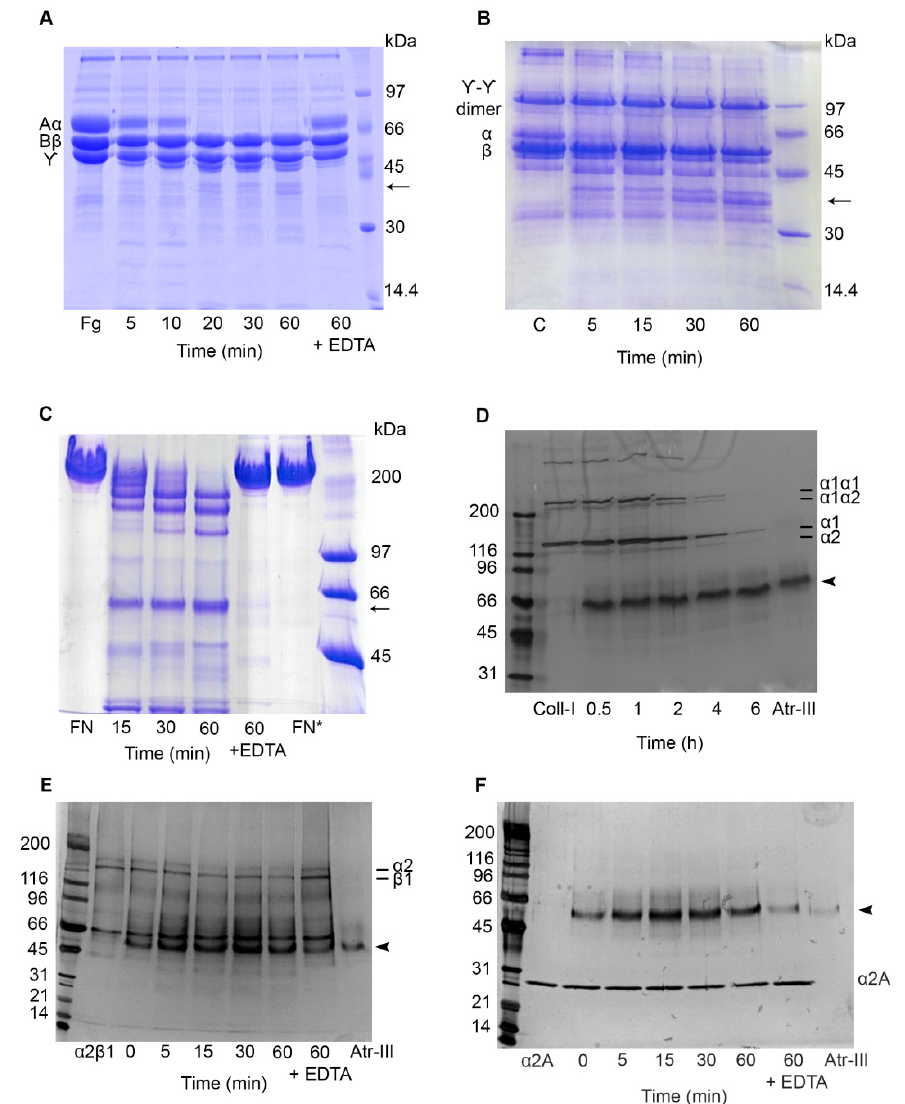
Figure 7. SDS-PAGE analysis of fibrinogen, fibrin, fibronectin, type I collagen, α 2 β 1 integrin and its recombinant α 2A-domain (r α 2A) after digestion with Atr-III. Digestion reactions of Fg ( A ), fibrin ( B ), FN ( C ), Coll-I ( D ), α 2 β 1 integrin ( E ) and its r α 2A domain ( F ) were carried out at molar ratio of 1:150 (enzyme / substrate) for Fg, fibrin and FN, and 1:50 for collagen I for the indicated intervals at 37 ◦ C. α 2 β 1 integrin or its r α 2A domain were incubated with 10 µ g / mL of Atr-III for the same intervals at 37 ◦ C. Reactions were stopped by addition of 10 mM EDTA. Aliquots of the incubation mixtures were analyzed by SDS-PAGE under reducing conditions in 12% gels for Fg and fibrin, 7% for FN and 5% for collagen I and 7–15% gradient gel for α 2 β 1 integrin and r α 2A domain. The positions of the three polypeptide chains of Fg control A α , B β and γ ( A ) as well as fibrin control γ - γ dimer, α and β ( B ) are indicated at the left. Typical type I collagen chains (cross-linked α 1 α 1, α 1 α 2, chain dimers, and monomeric α 1 and α 2) are indicated at the right ( D ). In panels E and F, α 2 β 1 or r α 2A-domain were incubated with 10 µ g of Atr-III for the indicated intervals. Reactions were stopped by addition of 10 mM EDTA and analyzed by SDS-PAGE (7–15% gradient gel). Controls of Atr-III in ( D ), ( E ) and ( F ) are indicated by black arrow heads. The results shown are representative of three similar experiments.